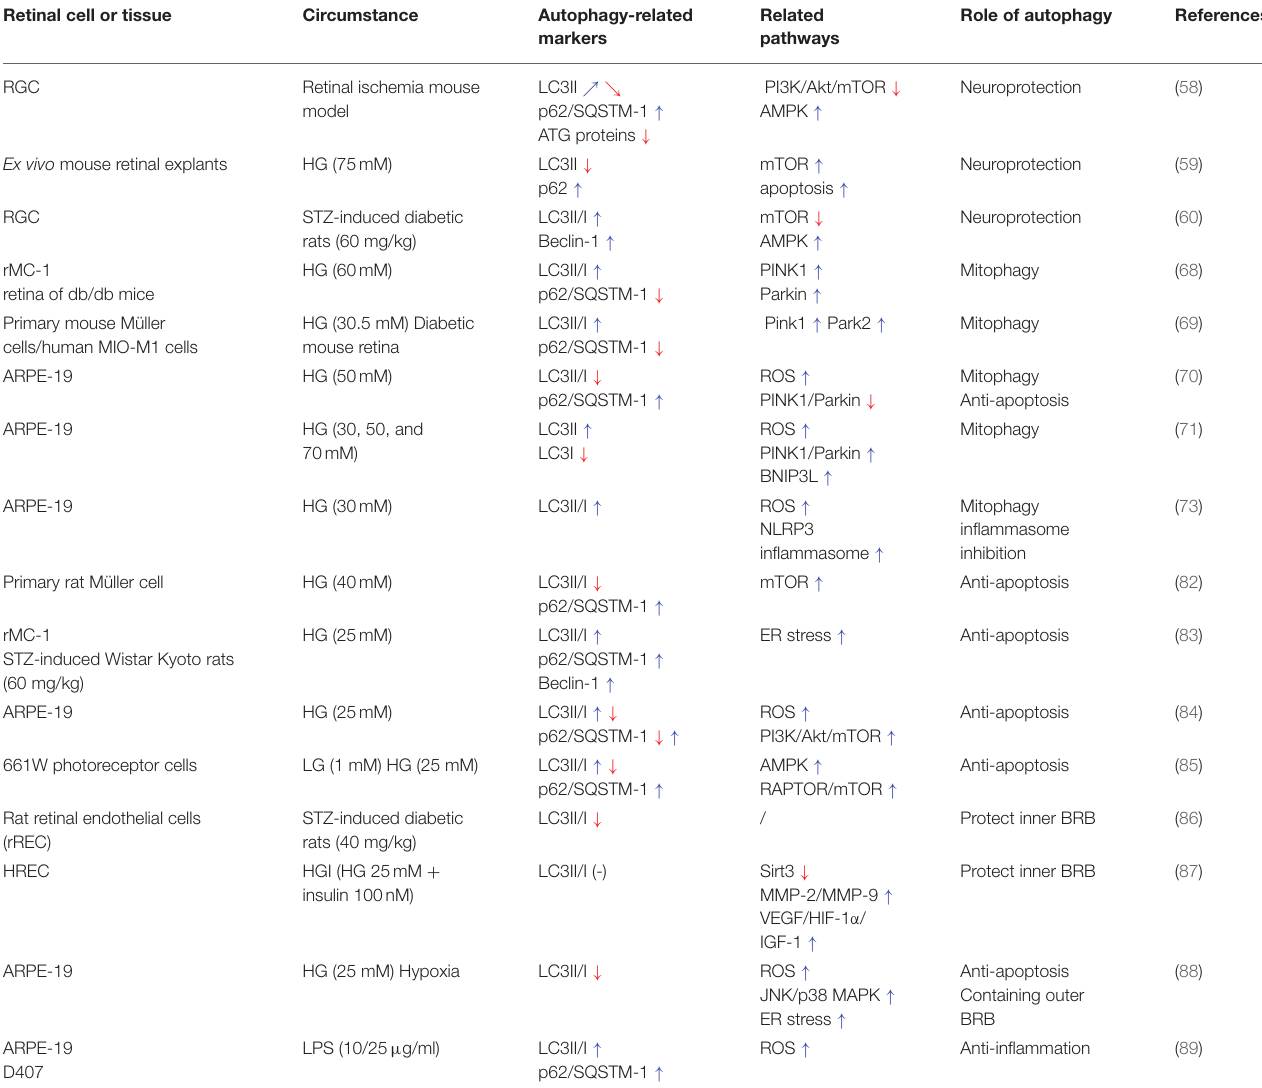
TABLE 1 | The mechanisms involved in protective roles of autophagy in